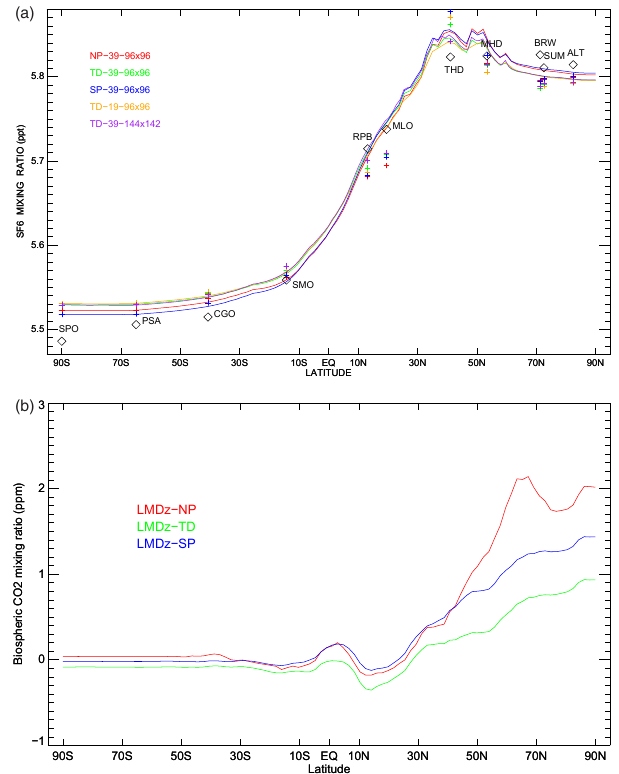
Figure 9. (a) Zonally averaged SF 6 surface dry mole fraction (inppt) for NP (red), TD (green) and SP (blue) configurations of LMDz using an horizontal resolution of 96 points in longitude by 96 points in latitude and with 39 vertical levels (96 × 96 × 39). Others resolutions (144 × 142 × 39 in purple, and 96 × 72 × 19 in orange) have also been tested using TD configuration. Also shown are SF 6 measurements (black crosses) at 11 surface stations coming from the NOAA/ESRL network (http://www.esrl.noaa.gov/gmd). (b) The rectifier effect. Surface zonal annual mean CO 2 dry mole fractions (in ppm) resulting from biosphere emissions only. The concentra- tions have been reduced by the global January mean concentration.